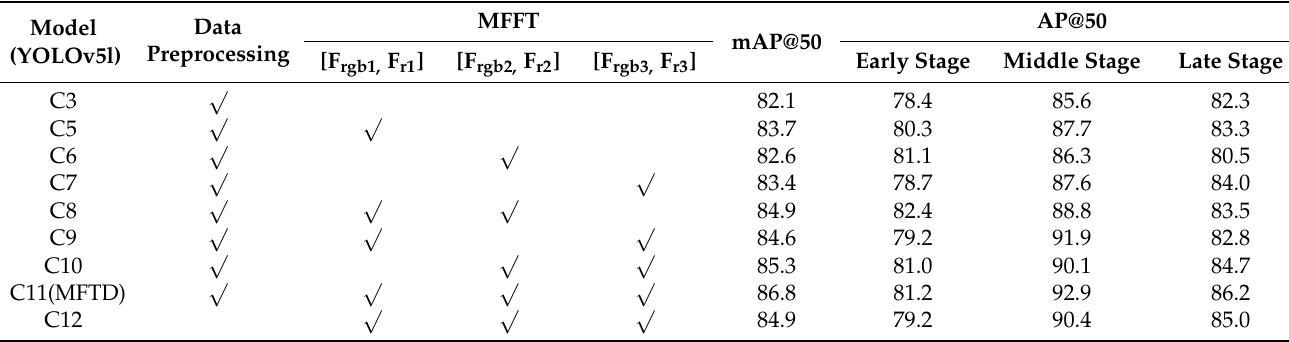
Table 7. Ablation Experiments on CP